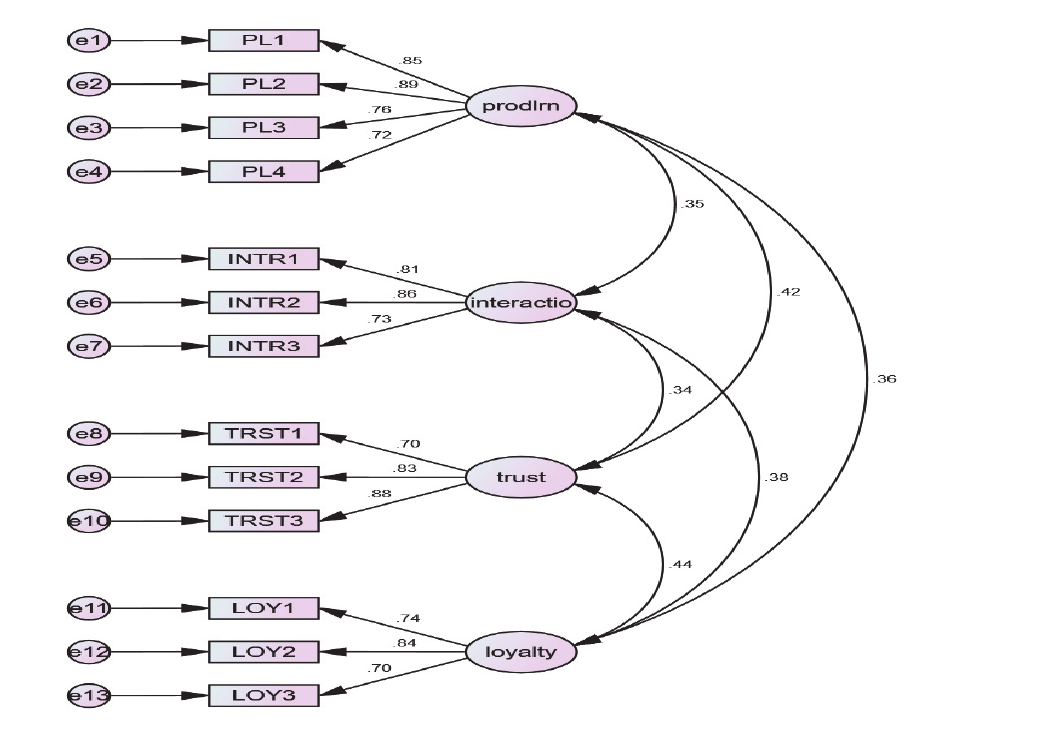
Fig. 2. Confirmatory Factor Analysis of the study